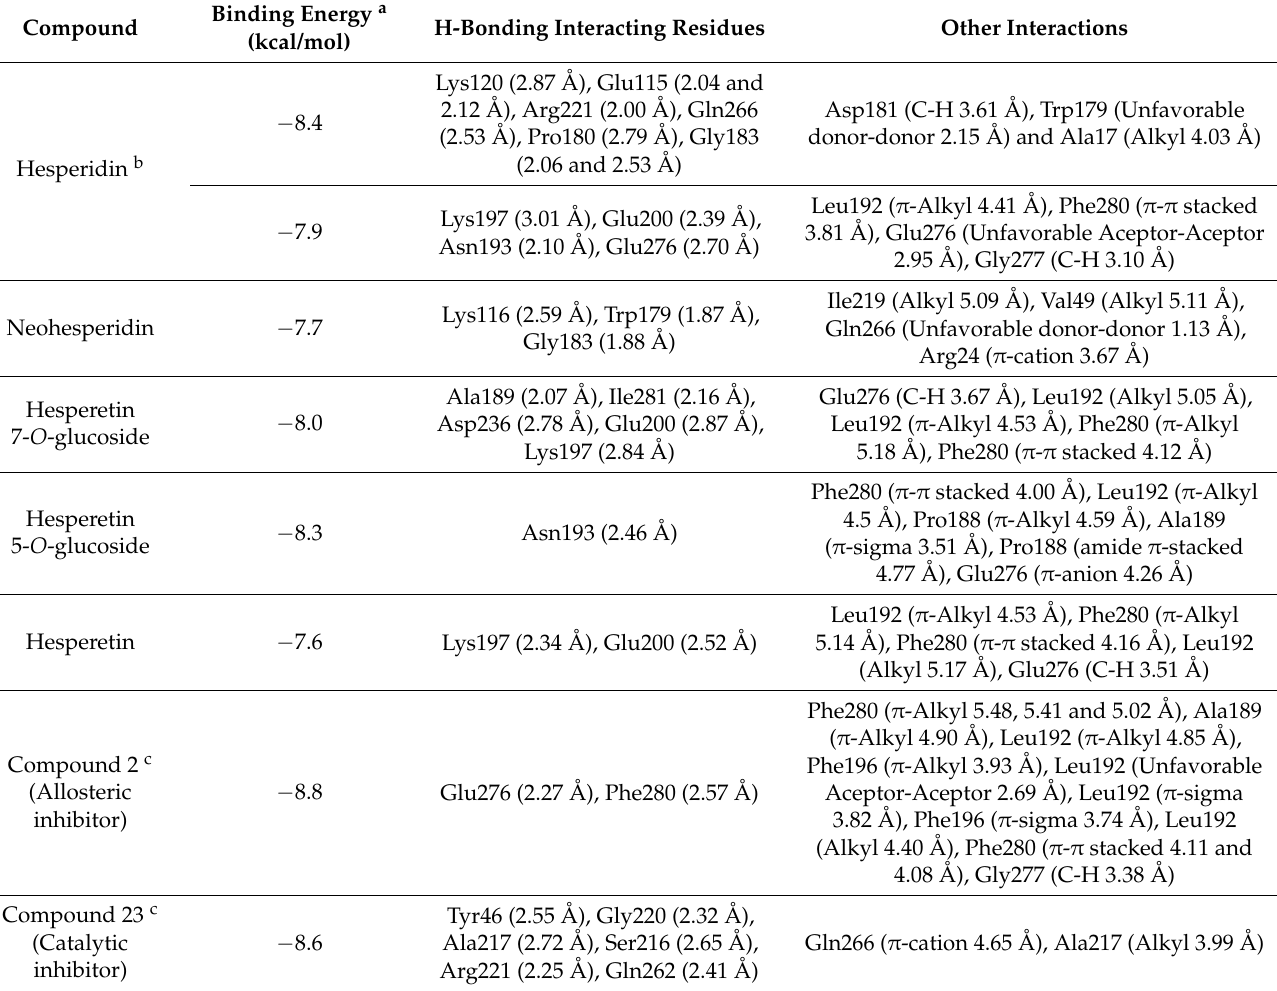
Table 2. Binding site residues and docking scores of flavonoids in the tyrosine phosphatase 1B protein using the AutoDock vina